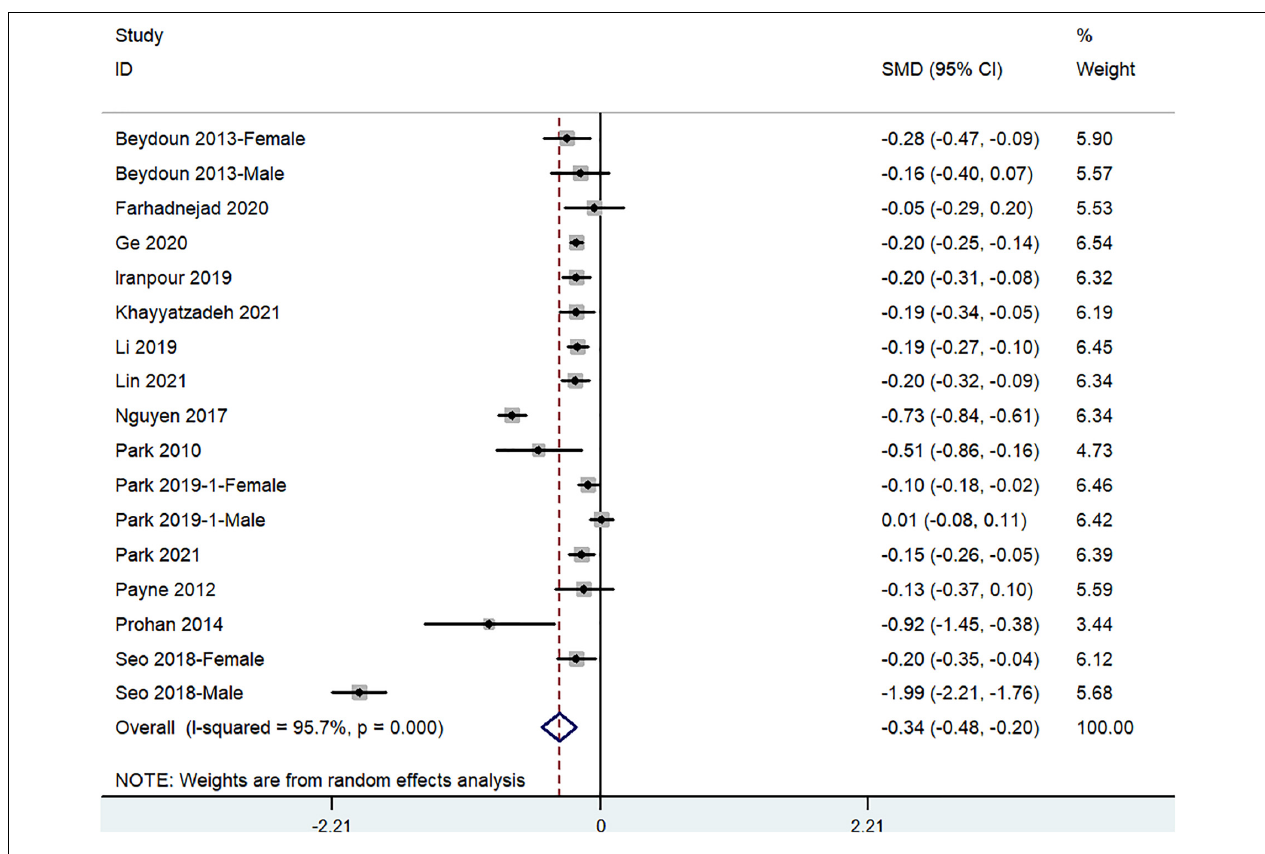
FIGURE 5 | Forest plot of meta-analysis: SMD of dietary beta-carotene intake for depression vs. control subjects. TABLE 5 | Subgroup analysis for SMD of dietary beta-carotene in depression vs. control